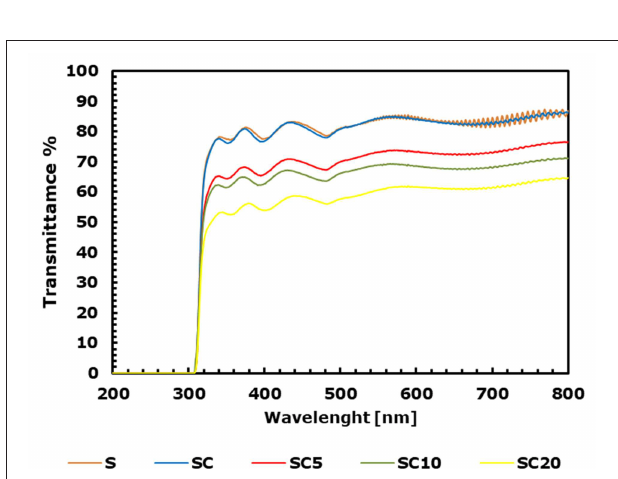
FIGURE 4 | UV-Vis transmission spectra of the neat PET substrate film (S) and for the SC coated films at 0, 5, 10 and 20% LAE concentration.